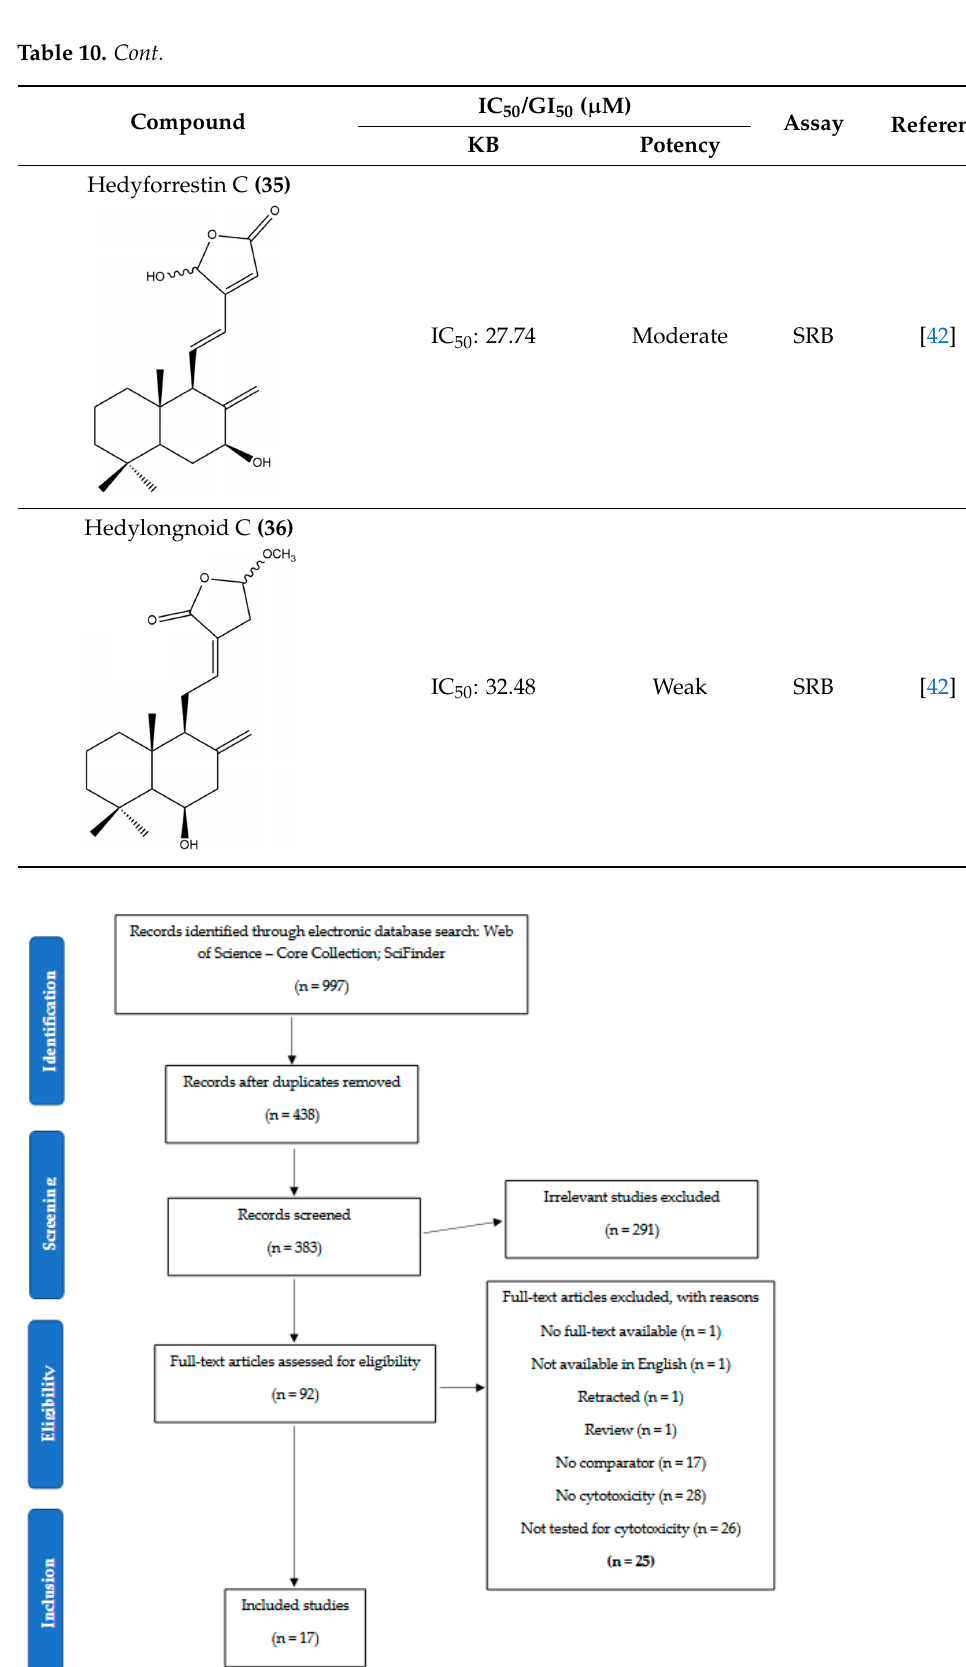
Figure 1. PRISMA flow chart for article selection. Table 3. Cytotoxic labdane-type diterpenes from the Zingiberaceae. Species